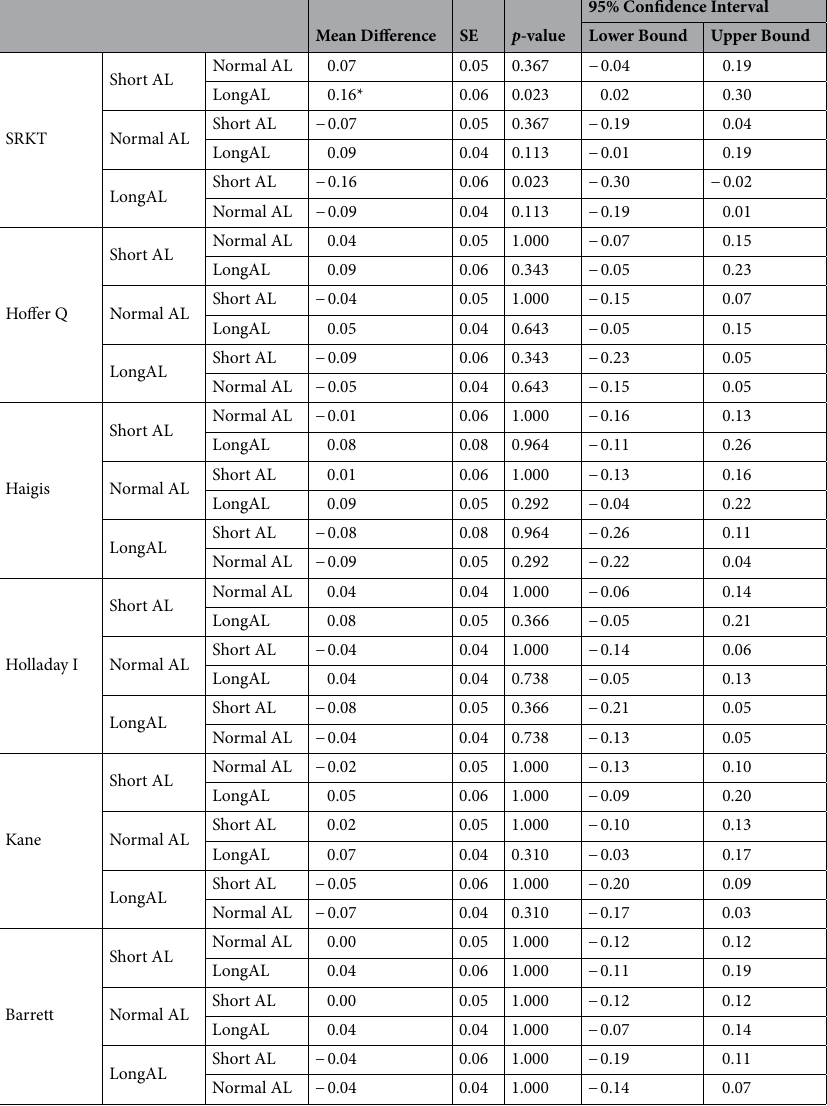
Table 3. Multiple comparisons. MAE mean difference. *The mean difference is significant at the 0.05 level. SE: Standarized